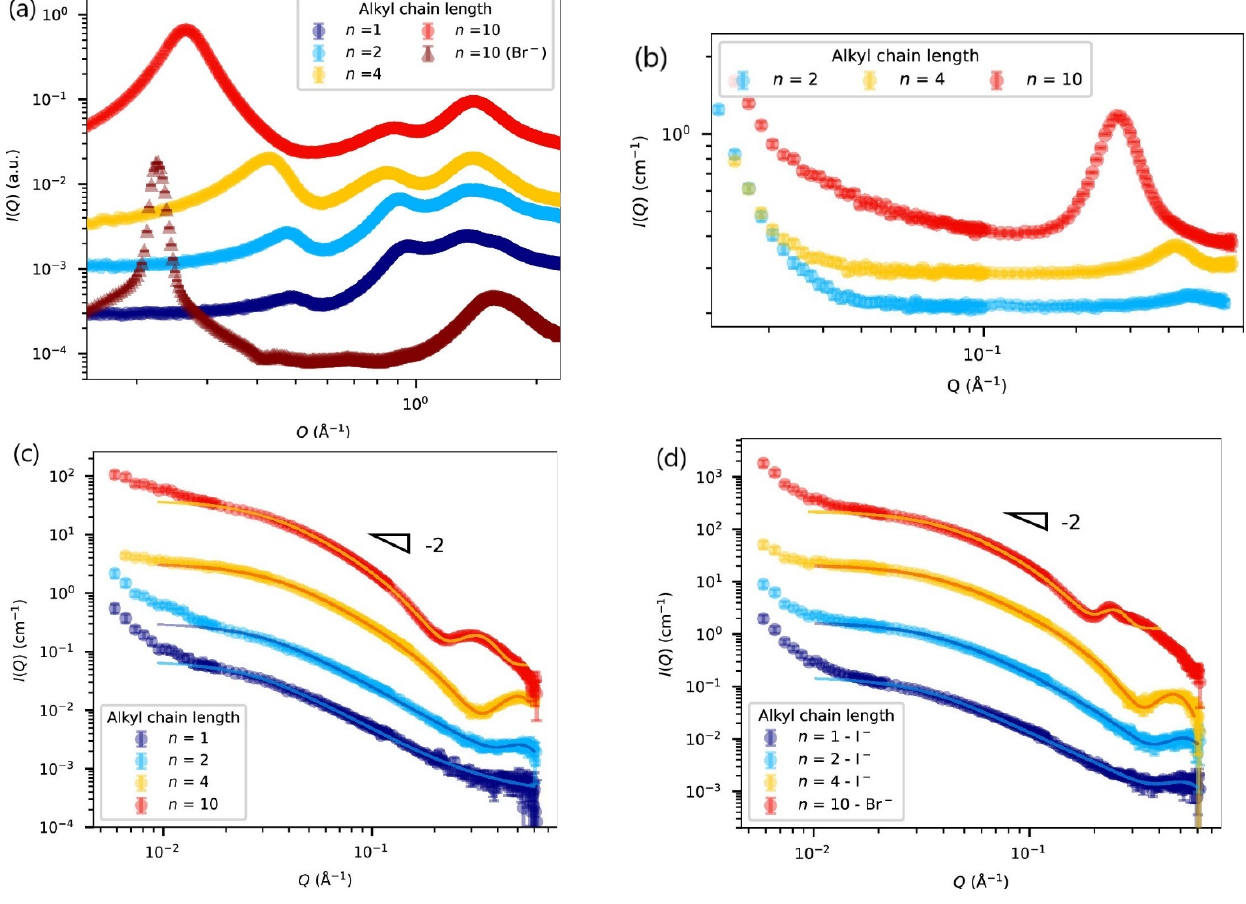
Figure 4. ( a ) WAXS data of bulk PCnTFSI (circle, open) with different alkyl side-chain lengths, n , and PC10Br (triangle, open), ( b ) SANS data of bulk purely deuterated PC n TFSI, ( c ) SANS data of bulk PC n TFSI H/D (1:1 w/w ), and ( d ) SANS data of bulk PC n I and PC10Br H/D (1:1 w/w ) with varying alkyl side-chain lengths, n . Solid lines correspond to the best model fits. All data in ( a )–( d ) are shifted vertically for clarity. All figures were readapted from Ref. [51].